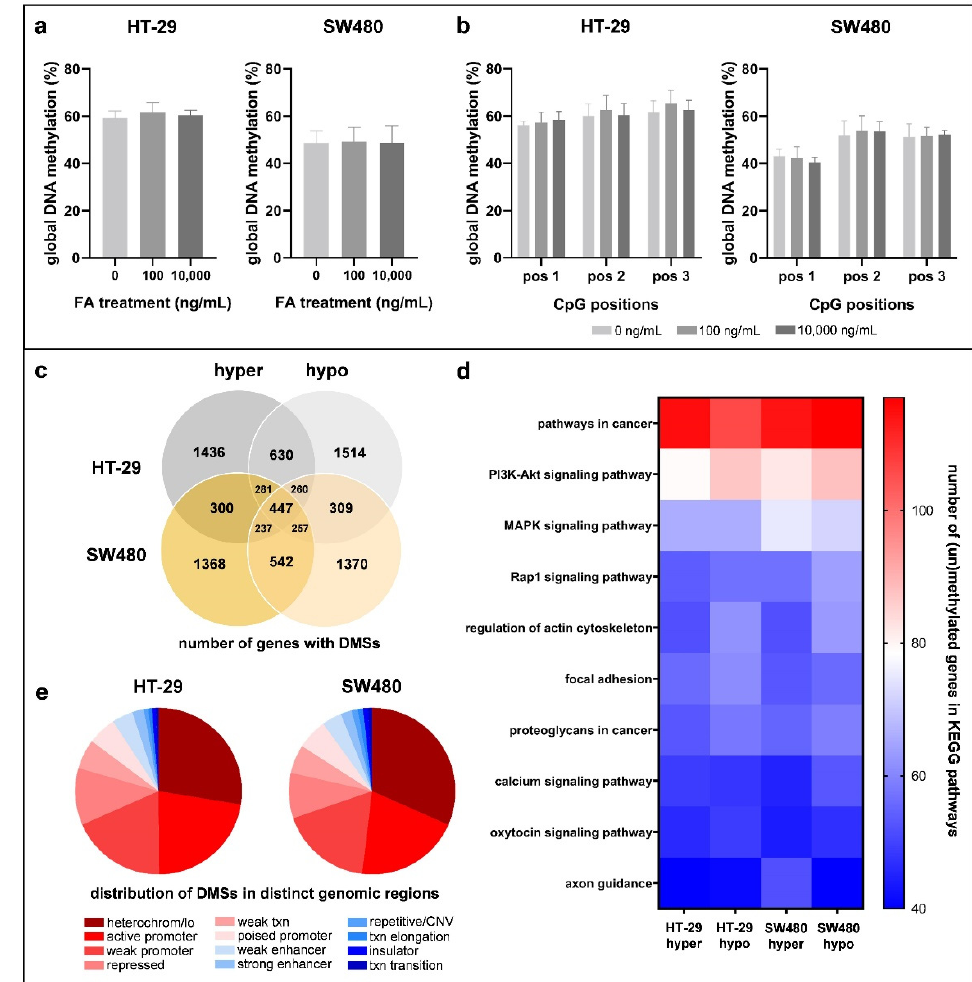
Figure 3. DNA methylation analysis of HT-29 and SW480 cell lines exposed to different folic acid (FA) concentrations. The methylation levels of long interspersed nuclear element 1 (LINE-1) CpG positions (pos 1, pos 2, pos 3) were ( a ) summarized and also ( b ) visualized individually to detect global DNA methylation changes. With the use of Reduced Representation Bisulfite Sequencing (RRBS) method, a genome-wide methylome profile of 10,000 ng/mL FA-treated cells was established in the comparison of cells kept in FA-free (0 ng/mL FA) media. ( c ) Firstly, the number of genes with altered methylation in the investigated CpG sites was assessed. “Hyper” and “hypo” sections indicate the number of genes with methylated and unmethylated CpG sites, respectively. The intersection of these two categories refers to the genes that possess both methylated and unmethylated CpG dinucleotides. ( d ) Heatmap shows the top 10 significantly ( p ≤ 0.05) enriched Kyoto Encyclopedia of Genes and Genomes (KEGG) pathways with the number of differentially methylated genes. ( e ) Pie charts represent the localization of differentially methylated sites (DMS) in distinct chromatin states. FA: folic acid; pos: CpG position; hyper: hypermethylation; hypo: hypomethylation; DMSs: differentially methylated sites; heterochrom/lo: heterochromatin or low signal region; txn: transcription; CNV: copy number variation; KEGG: Kyoto Encyclopedia of Genes and Genomes.